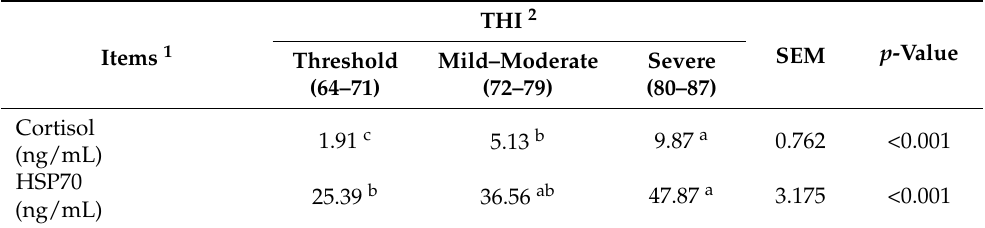
Table 3. Effect of heat stress level on blood cortisol and heat shock protein 70 levels in Korean native beef steers.